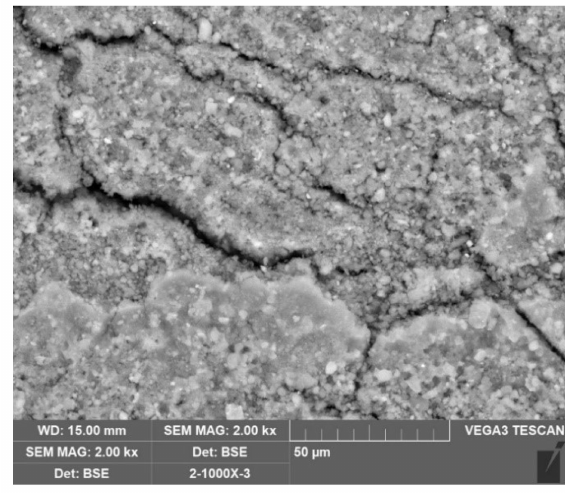
Figure 8. SEM image of coating surface (2.00 kx).